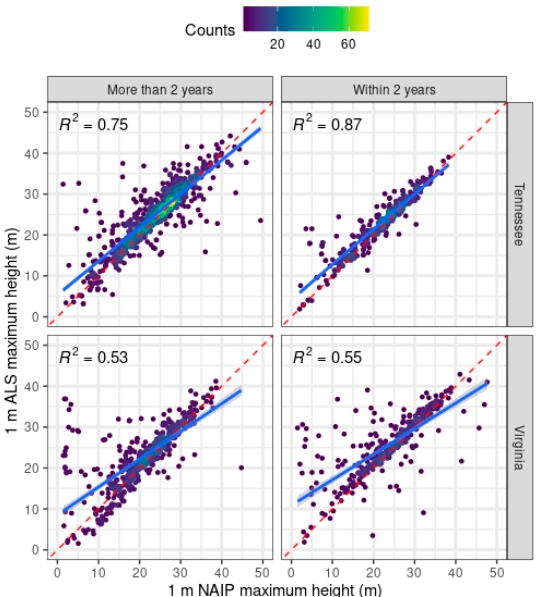
Figure 5. Comparison of the 1 m ALS and 1 m NAIP point cloud heights at the FIA plot locations. Columns split the dataset into the plots where ALS was collected more (left) or less than 2 years from the NAIP acquisitions, which were collected in 2018; rows break out the plots collected in TN (top) and VA (bottom). Shading from blue (low) to yellow (high) indicates the density of observations in places with multiple overlapping plots. Blue lines are the reduced major axis regression (RMA) fits and the red dashed lines are the 1:1 lines.